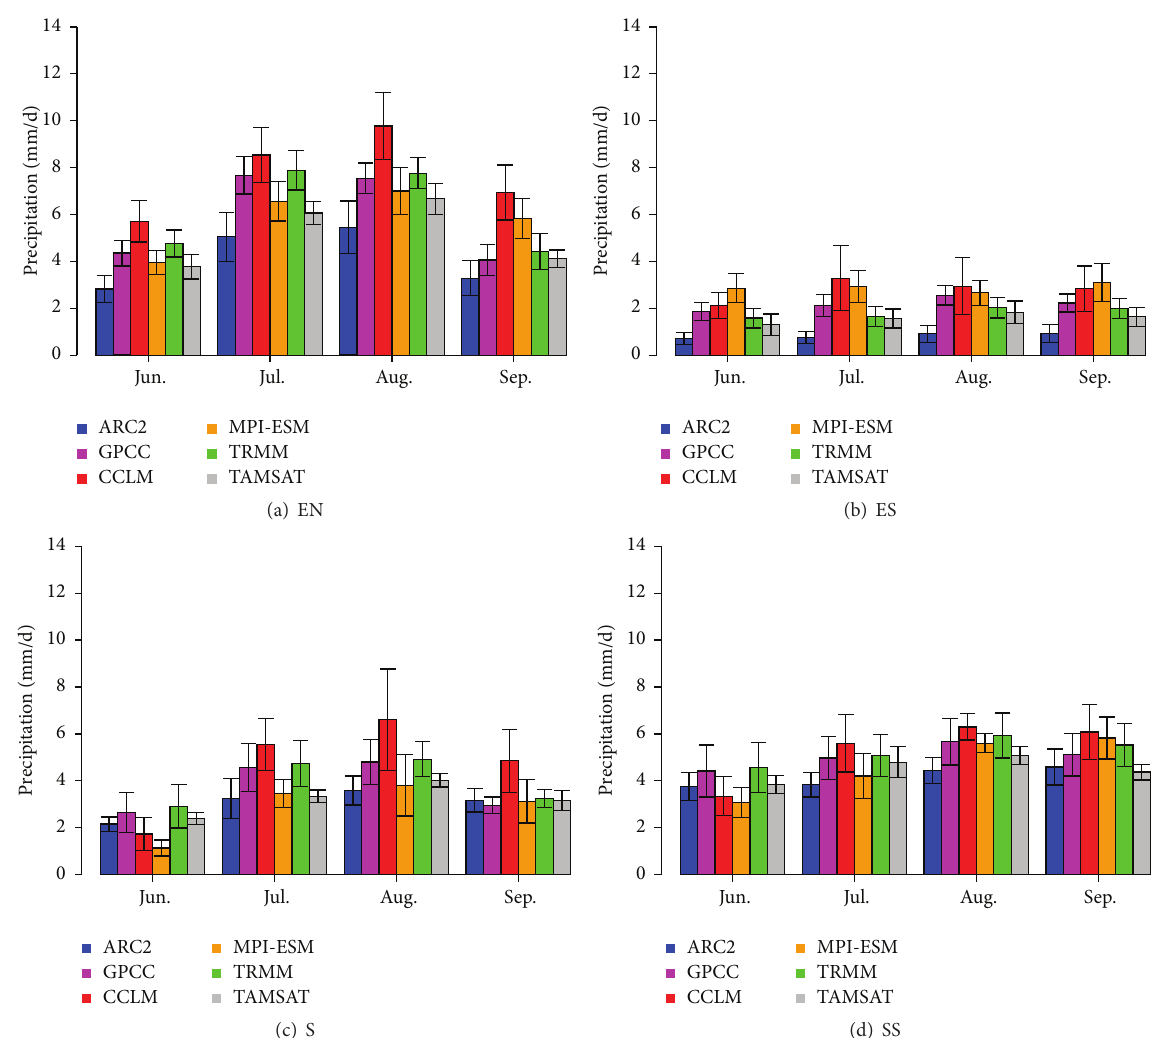
Figure 4: Daily mean precipitation (mm/d) of June to September averaged over the selected regions. Bars indicate the standard